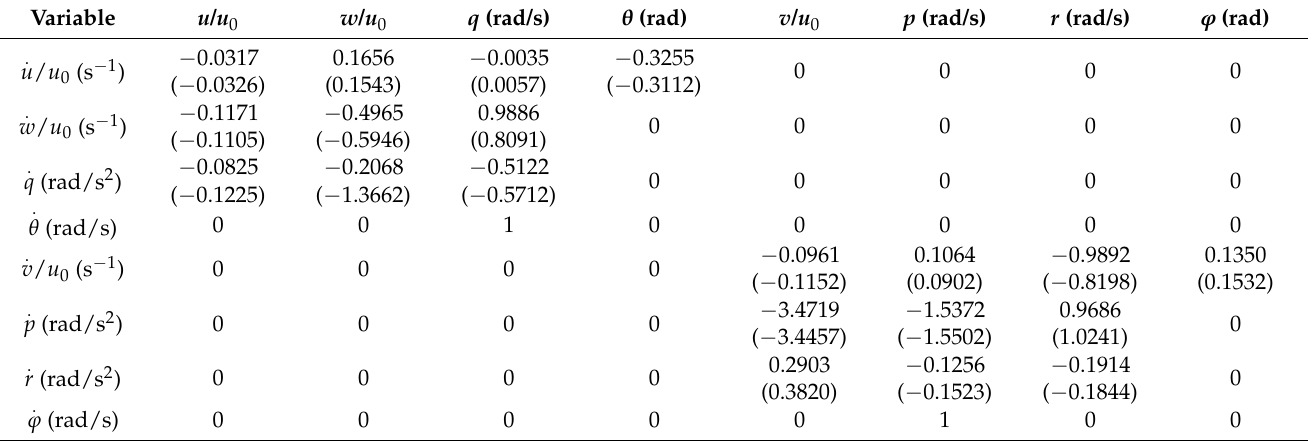
Table 27. CFD–RANS (extrapolated) 8 × 8 stability matrix for flight condition 21 in Tables 4 and 22 (reference takeoff case).